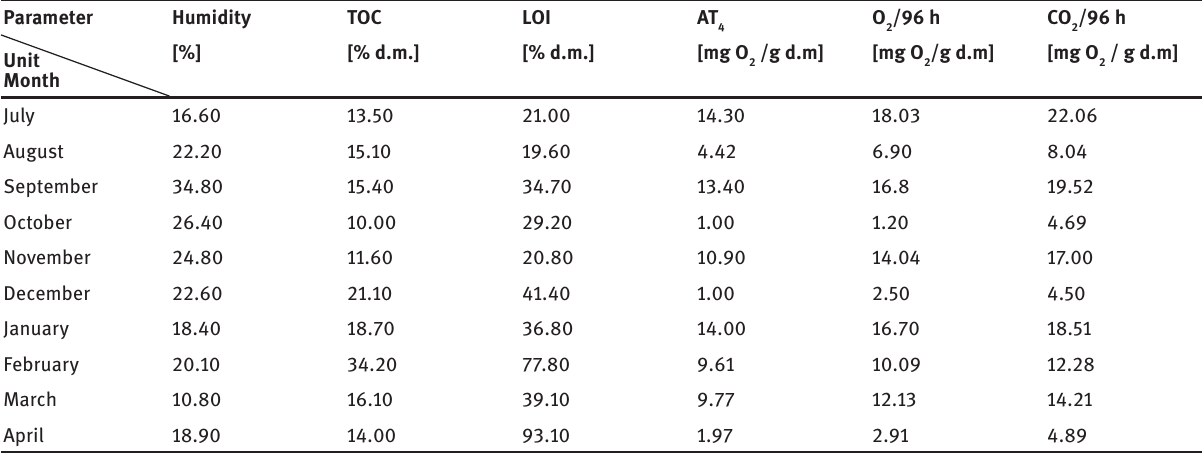
Table 5: Characteristic of the 20-80 mm fraction after processing in the bio-reactor. Parameter Humidity TOC